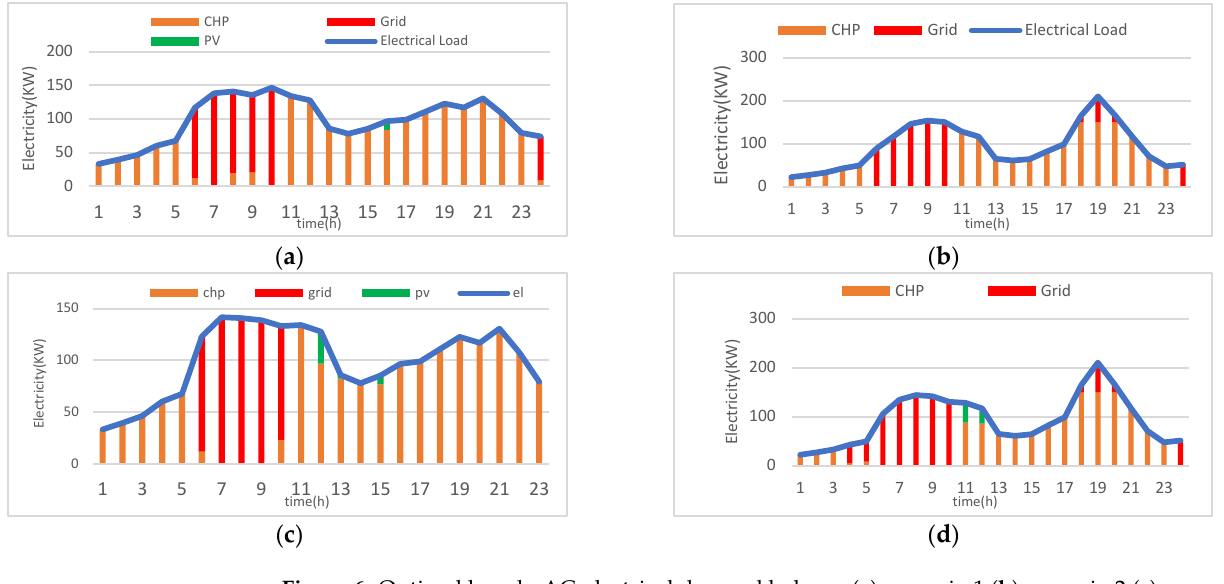
Figure 6. Optimal hourly AC-electrical demand balance ( a ) scenario 1 ( b ) scenario 2 ( c ) scenario 3